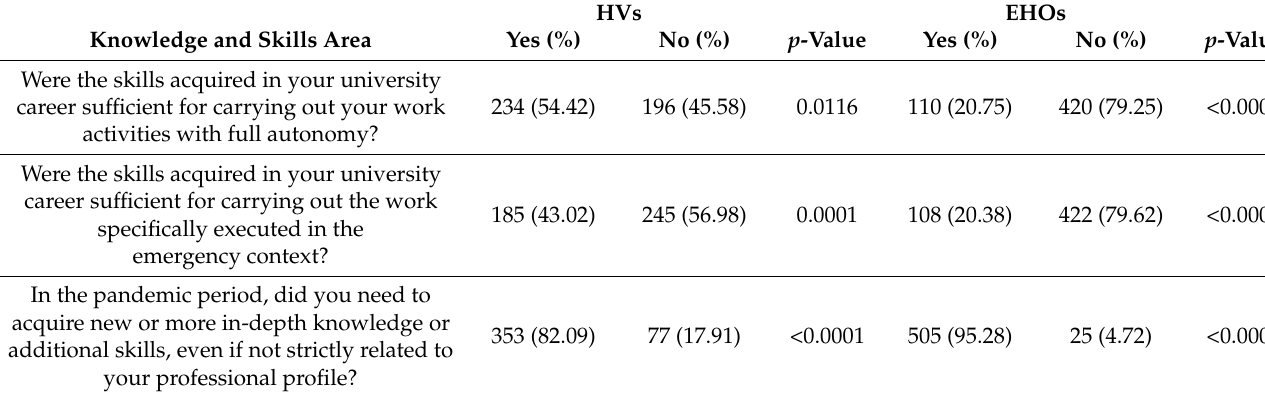
Table 5. Knowledge and skills declared in the